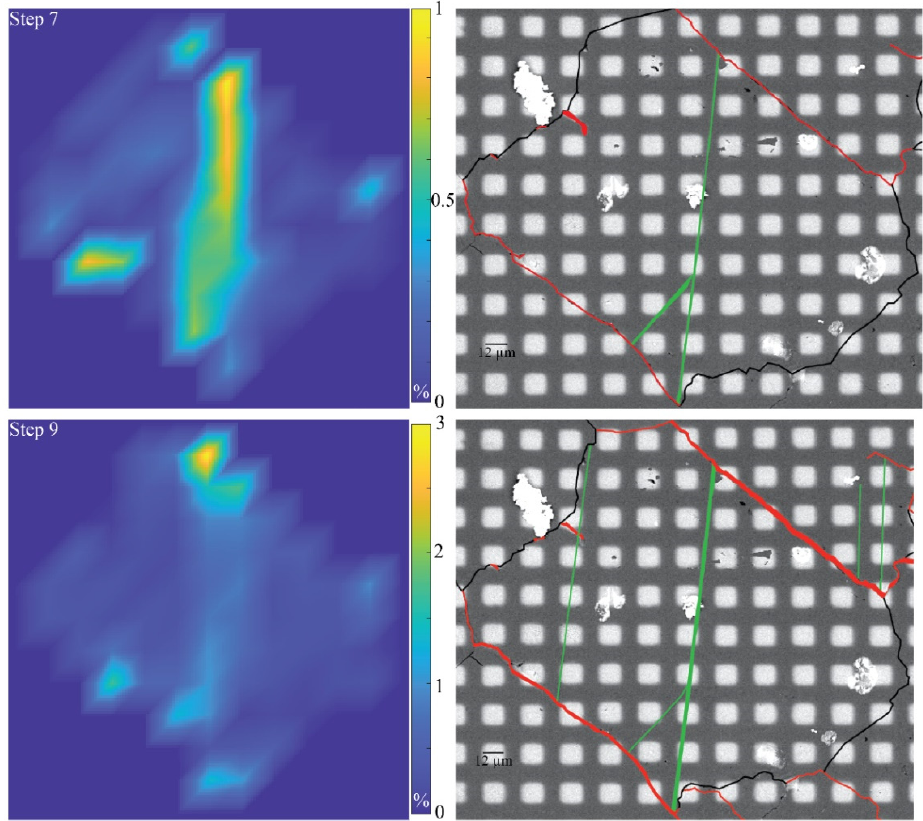
Figure 19. Equivalent Von Mises deformation map of crystal 12 at different steps of sample defor- mation. The black lines represent the grain boundaries. The green lines show the twinned planes. The red lines show the fracture zones.